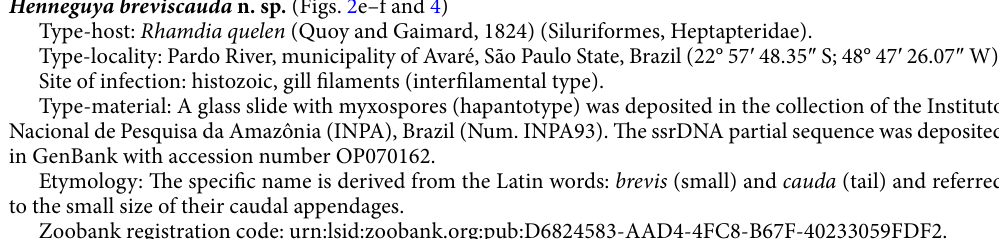
ments, occupying an interfilamental position. Average one plasmodia per parasitized fish. Myxospores: The morphological data are based on the observation of myxospores isolated from a single plasmodium. The myxospores found were elongated and ellipsoidal in frontal view. Two elongated, elliptical shell valves with two small tapering caudal appendages. Average measurements: total length 17.1 ± 0.9 (15.9–18.7) µm, body length 10.7 ± 0.4 (9.6–10.8) µm, body width 5.3 ± 0.5 (4.4–6.1) µm, caudal appendages length 7.2 ± 0.8 (5.8–8.2) µm. Myxospores were biconvex in the lateral view with a thickness of 3.7 ± 0.1 (3.6–3.9) µm. The polar capsules were unequal in size. The larger polar capsule measured 5.4 ± 0.2 (5.1–5.6) µm in length and 1.5 ± 0.1 (1.2–1.6) µm in width, while the smaller polar capsule measured 4.6 ± 0.3 (4.2–5.0) µm in length and 1.2 ± 0.1